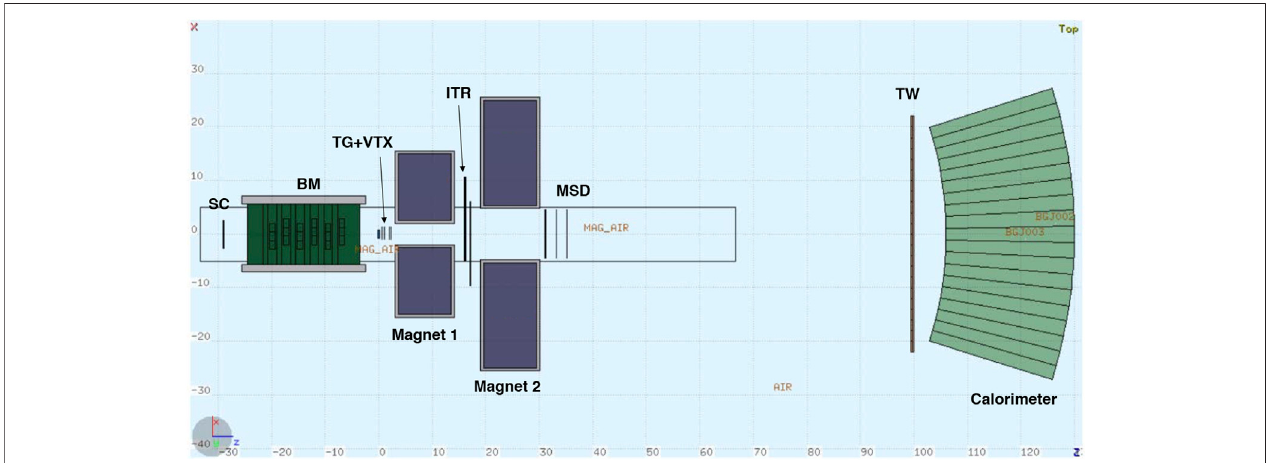
FIGURE 7 | 2-D top view of the full FOOT setup geometry implemented in the FLUKA MC simulation.